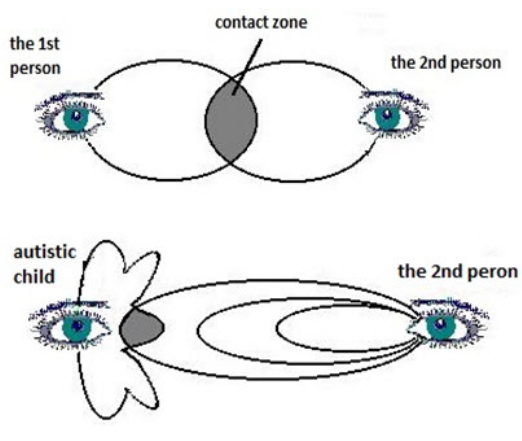
Figure 2. The diagram of communica - tion of a “normal” person as distinct from peo - ple with ASD. Source: Chermenskaya, 2014 . Some of the people with ASD perceive other people only at the level of objects. The